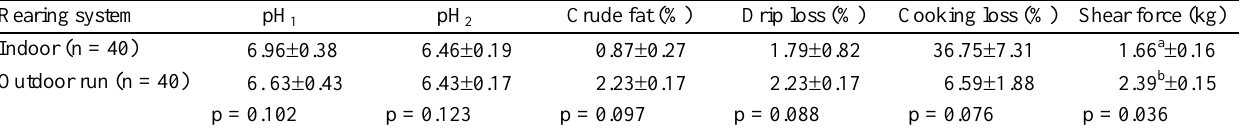
Table 4. Effect of rearing system on meat quality